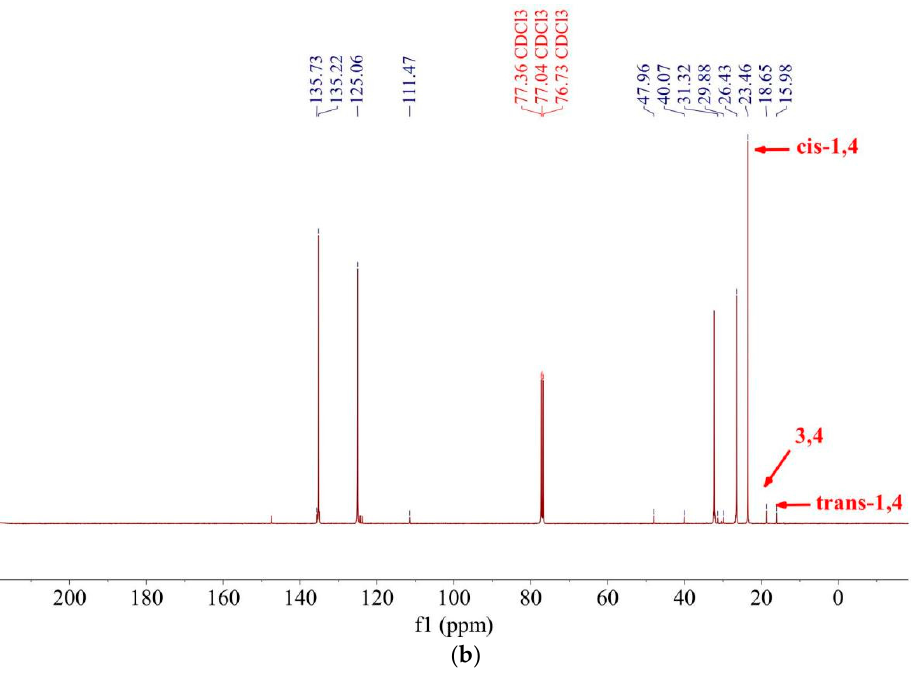
Figure 2. Representative 13 C NMR spectra of PIR samples from toluene and hexane: ( a ) 13 C NMR spectrum of PIR sample from toluene; ( b ) 13 C NMR spectrum of PIR sample from hexane.